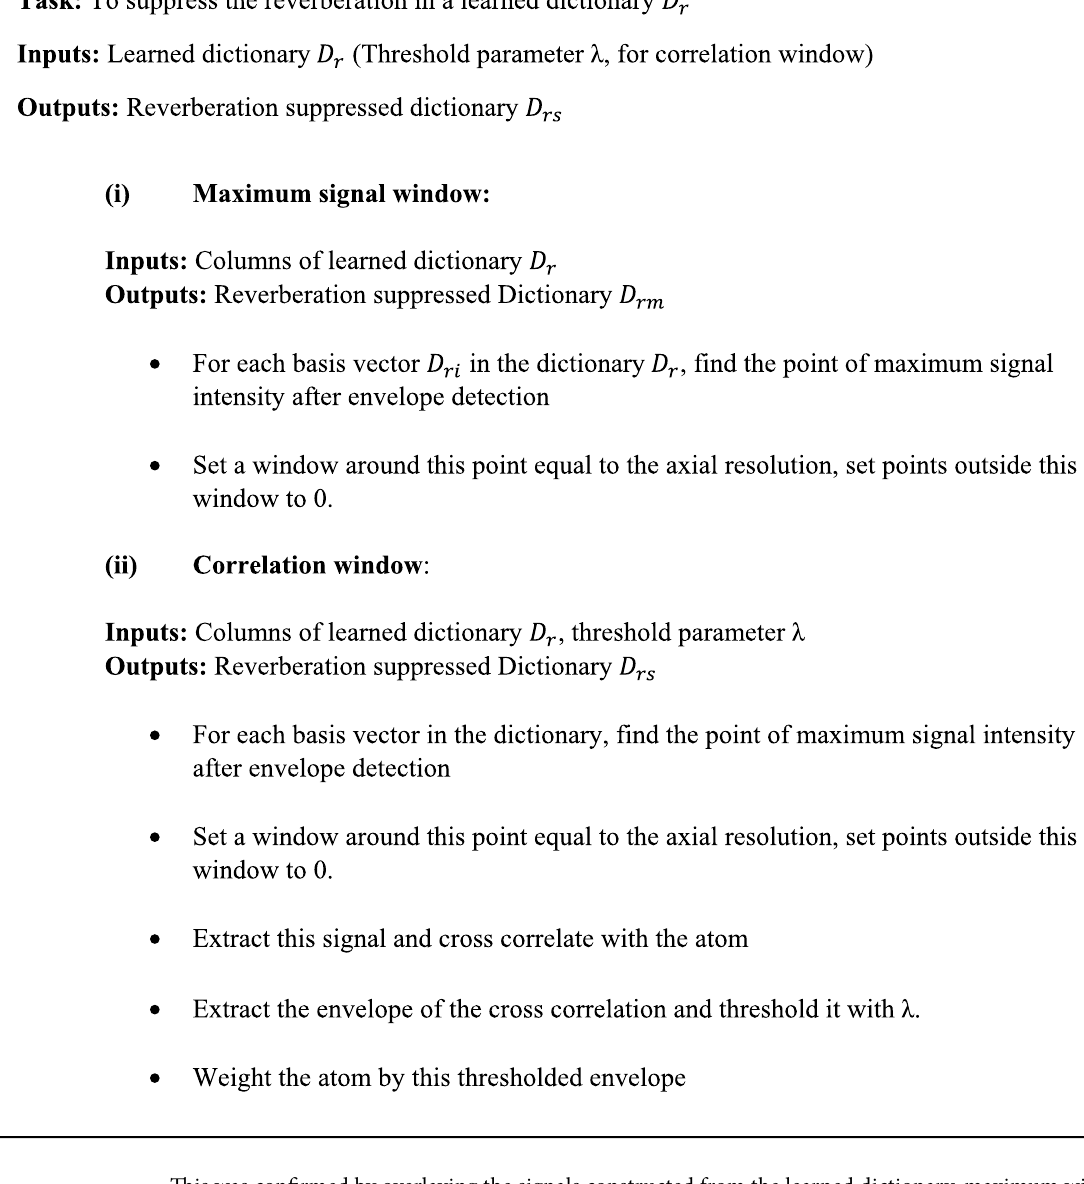
This was confirmed by overlaying the signals constructed from the learned dictionary, maximum window suppressed signal, and correlation window suppressed signal on a binary mask constructed from the raw B-scan. The mask was constructed by choosing regions of the B-scan image which are above − 40 dB relative to the maxi- mum. The ground truth B-scan (Fig. 5a) overlaid on the same masked area is shown for reference. No significant difference can be observed between Fig. 5a and b, illustrating that the dictionary is correctly capturing perti- nent signals. Additionally, it can be observed from Fig. 5c and its corresponding zoomed inset that although the reverberant artifacts (white arrows) are suppressed, there is also loss of signals of small amplitude (red arrows). However, when the correlation weighted window is used (Fig. 5d) the signals of small amplitude are retained, while the reverberation is suppressed. In vitro validation. For the in vitro experiments, data were acquired using 6- μ m-diameter dyed polystyrene beads (Polysciences Inc.) embedded in transparent PDMS (Sylgard 184, Dow-Corning), as shown in Fig. 6a. Since PDMS is optically transparent, this allows us to have a known distribution of optical absorbers without potential signal from the background. The data were acquired using the setup shown in Fig. 2a. A representative B-scan of the results is shown in Fig. 6b. It may be observed in Fig. 6c that the signal and reverberation are coded accurately using the learned dictionary which is confirmed in the corresponding zoomed insets. The result of